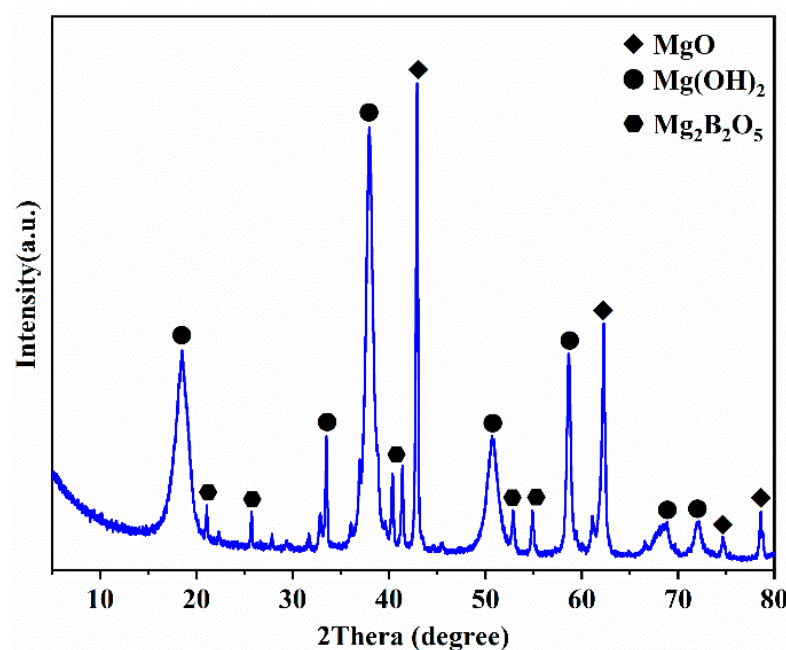
Figure 2. XRD pattern of magnesium residue before calcination.